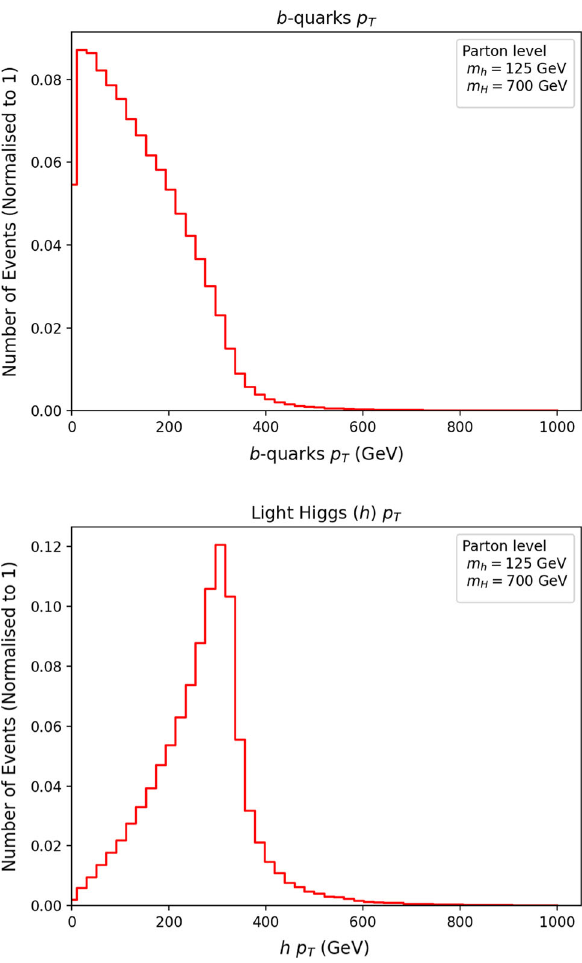
Fig. 3 Upper panel: transverse momenta of the final state b -quarks. Lower panel: transverse momenta of the lights Higgses before shower- ing and